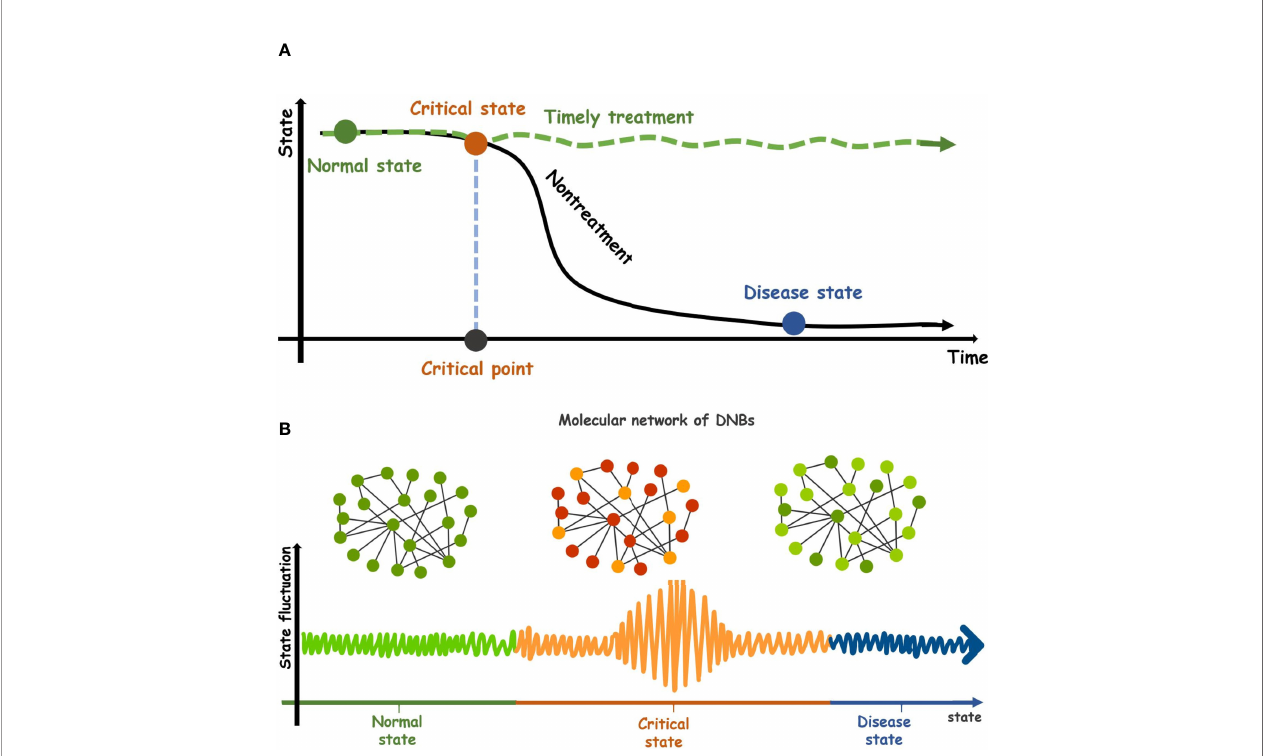
FIGURE 1 | Dynamic evolution of complex diseases. (A) The dynamic characteristics of a complex disease. Its progression can be divided into three states, a relatively healthy state (normal state), a critical transition state (pre-disease state), and a disease state. After the critical state of complex diseases is successfully detected and given timely treatment, the system will return from the critical state to the normal stage (green curve). Conversely, the system will go through the critical stage and enter the disease state. (black curve). (B) Three states in the molecular networks of DNBs during disease progression. The critical state is the limit point of normal state and is characterized by low stability and